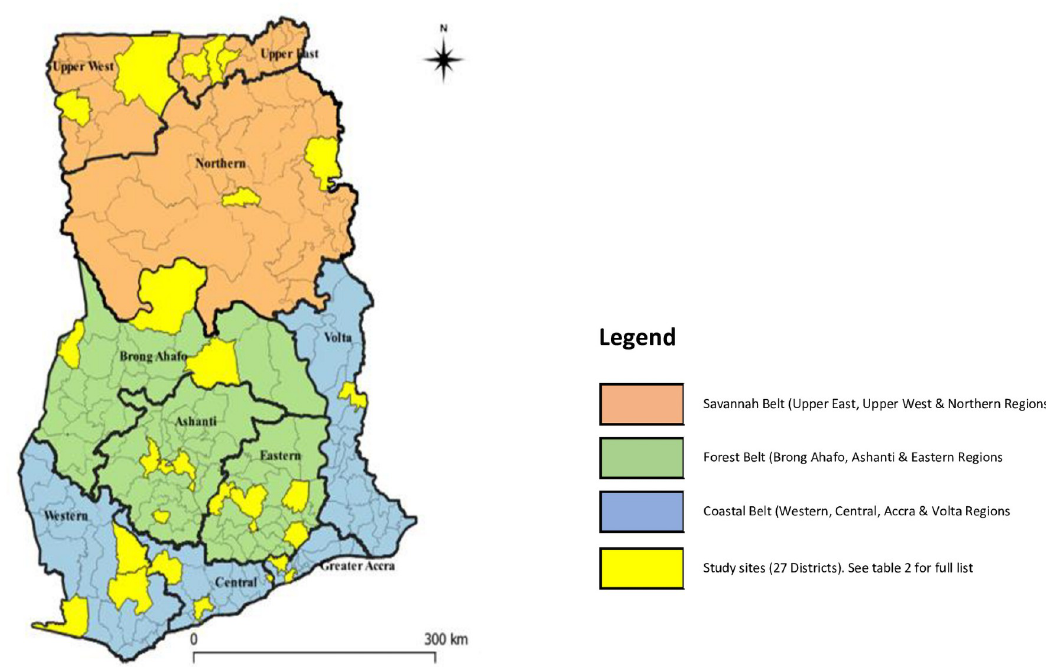
Fig 2. A map of Ghana showing the 10 regions and the study sites.